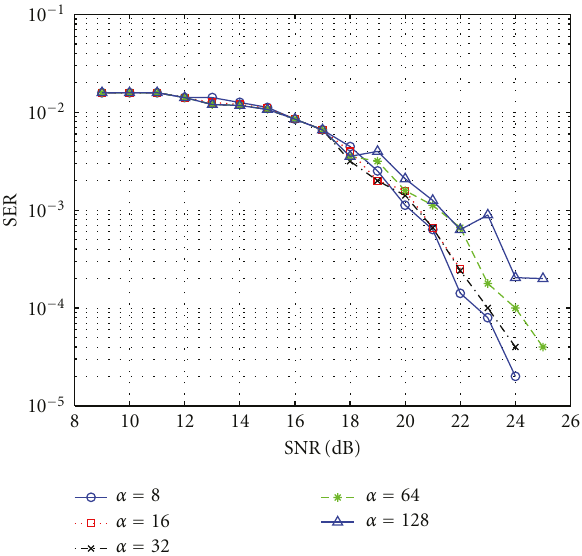
Figure 7: CEQTR SER × SNR having α = α max = 1 /p 0 as a parameter, with p 0 being the random tap picking probability in the DTA procedure of Algorithm 2. “Brazil A” channel profile, no Doppler. Notice that the best performance is obtained for α max = 16, value also found for “Brazil B–E” profiles.